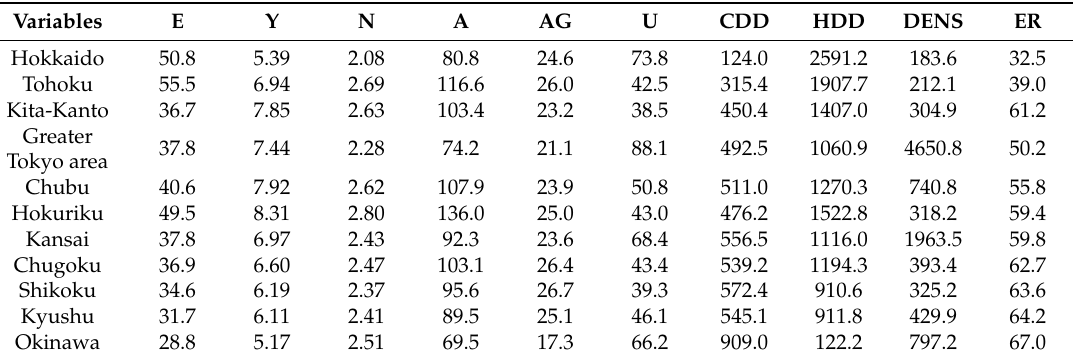
Table 2. Characteristics of Japanese Regions, FY